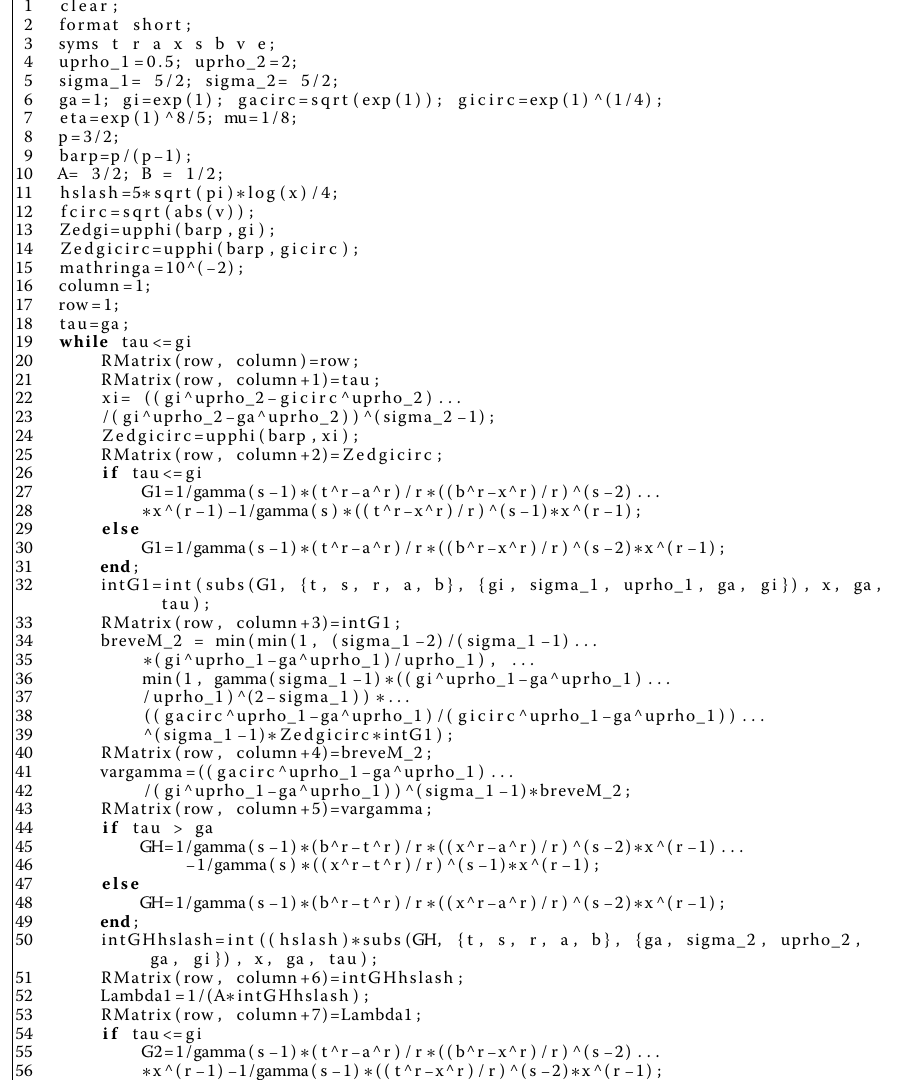
Algorithm 2 (MATLAB lines for calculation of variable values in Example